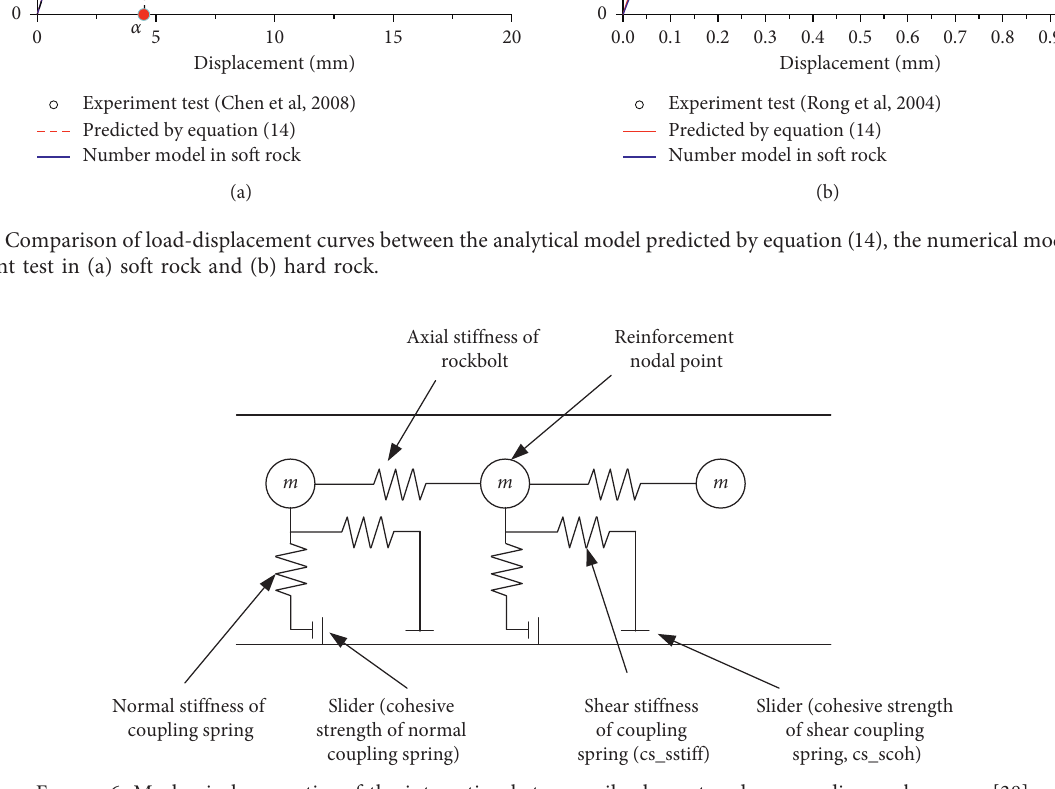
Figure 6: Mechanical properties of the interaction between pile element and surrounding rock masses [38].